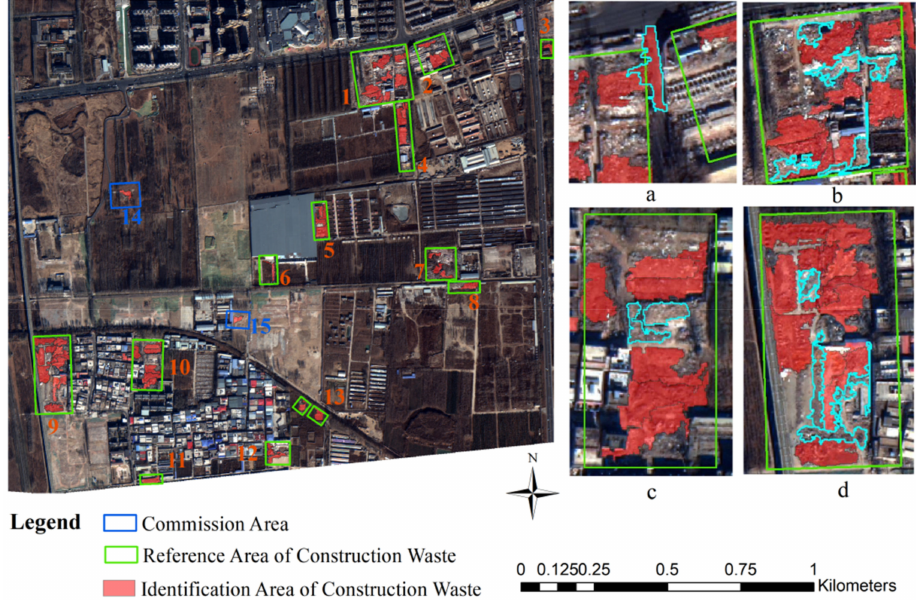
Figure 14. Separability analysis of study area A: ( a – d ) the image objects in the construction waste accumulation area were not all identified, which results in the omission phenomenon.